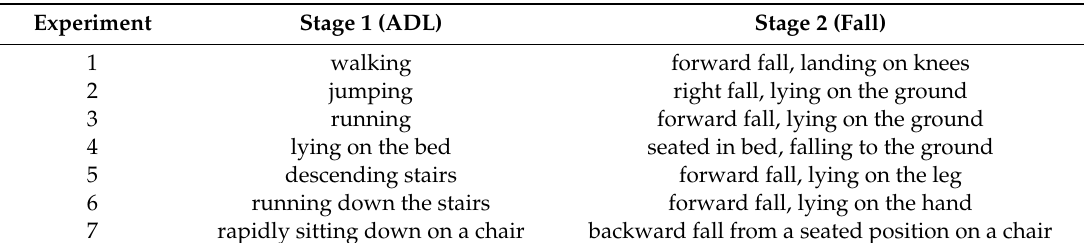
Table 1. ACC classification experiments, with scenarios for seven types of ADLs and seven types of falls.